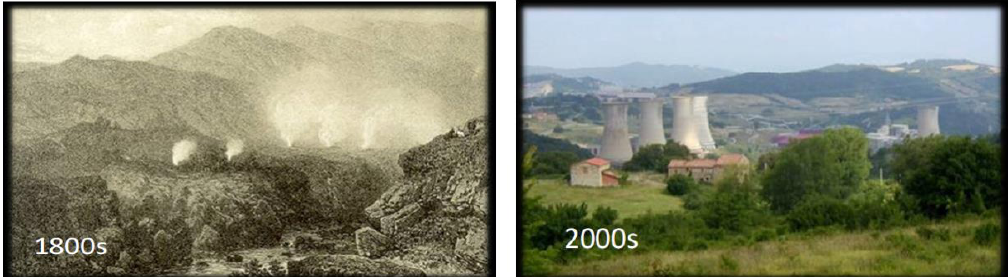
Figure 2. Picture of the Larderello area at different times.